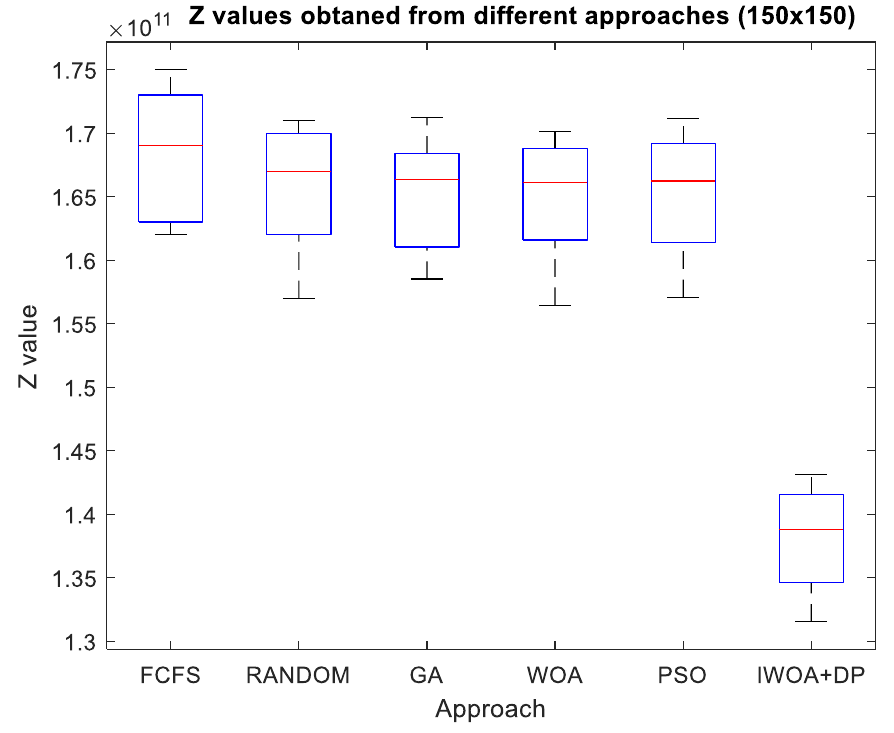
Figure 15. The box-whisker plot chart of Z values found for the problems (150 × 150).